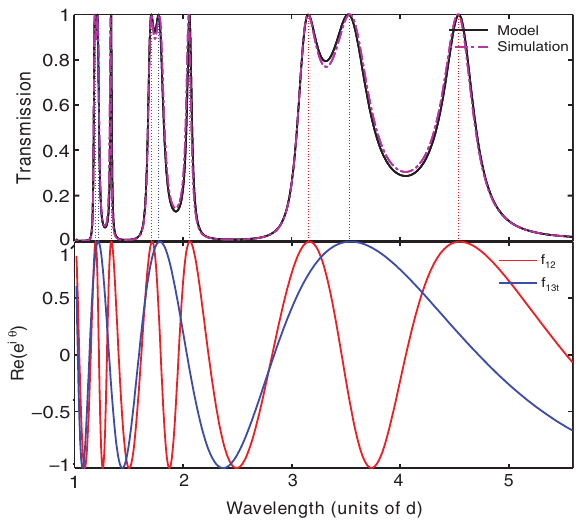
Figure 4: Transmission of the MIM periodic structure for dimen- sions a = 0.25 d , h